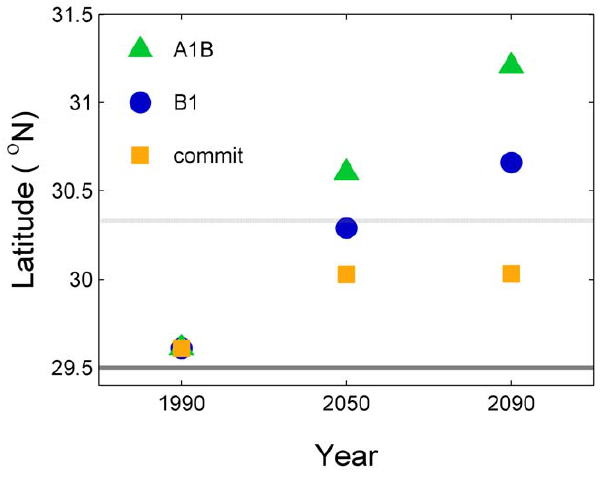
Figure 6. Estimated northern range limit of gray snapper during three time periods and under three emission scenarios. The heavy and light gray lines represent the estimate of current northern range limit and standard error as determined from field observations [39].